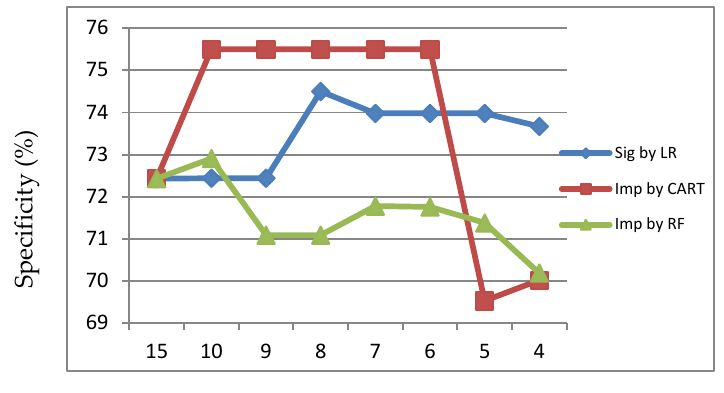
Figure 16. Specificity of LR with input of significant or important variables.